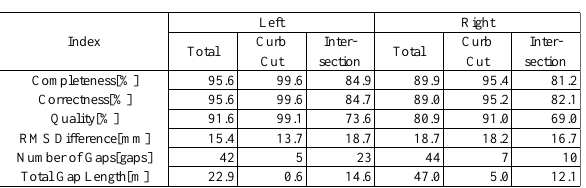
Table 3. The Result of quantitative evaluation at the scan site of Sapporo city